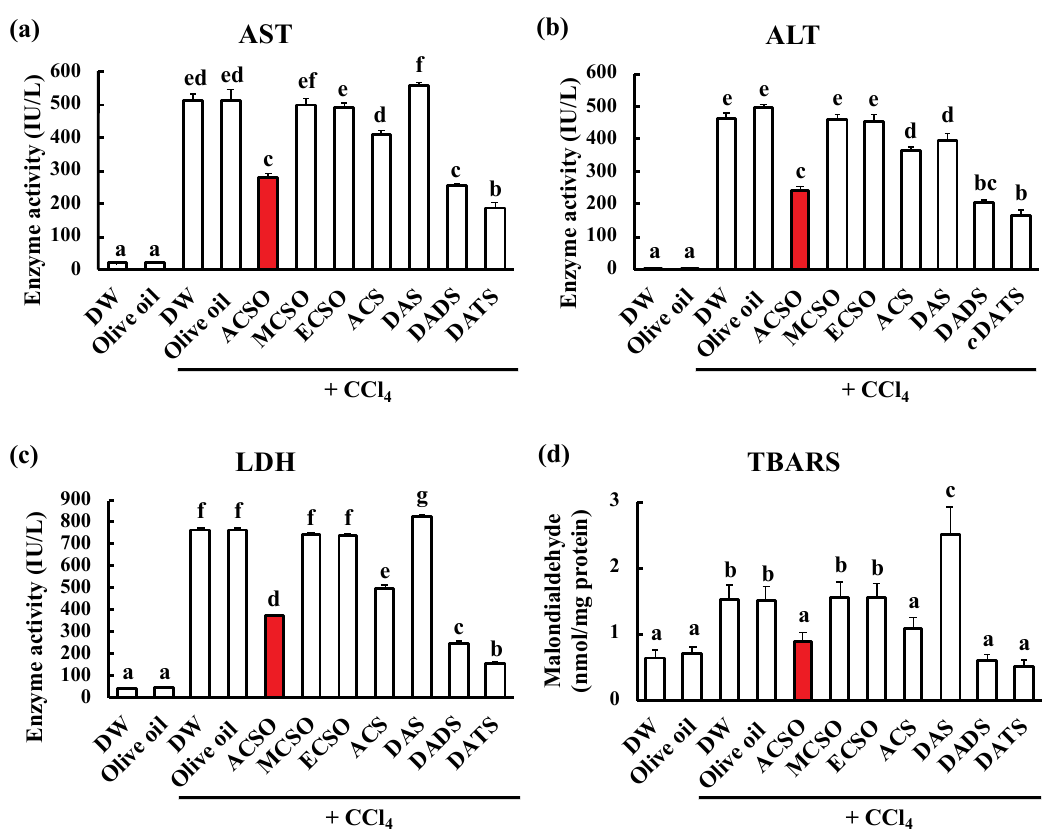
Figure 3. Effect of ACSO, its analogs, and garlic-odor compounds on markers for hepatic injury and oxidative stress. Aspartate transaminase (AST) activity ( a ), alanine transaminase (ALT) activity ( b ), lactate dehydrogenase (LDH) activity ( c ), and the amount of thiobarbituric acid reactive substances (TBARS) ( d ) in the blood of rats with CCl 4 -induced hepatic injury. Each value represents the mean of six rats ± S.E. The different letters in the figures indicate a significant difference between the groups ( p < 0.01).